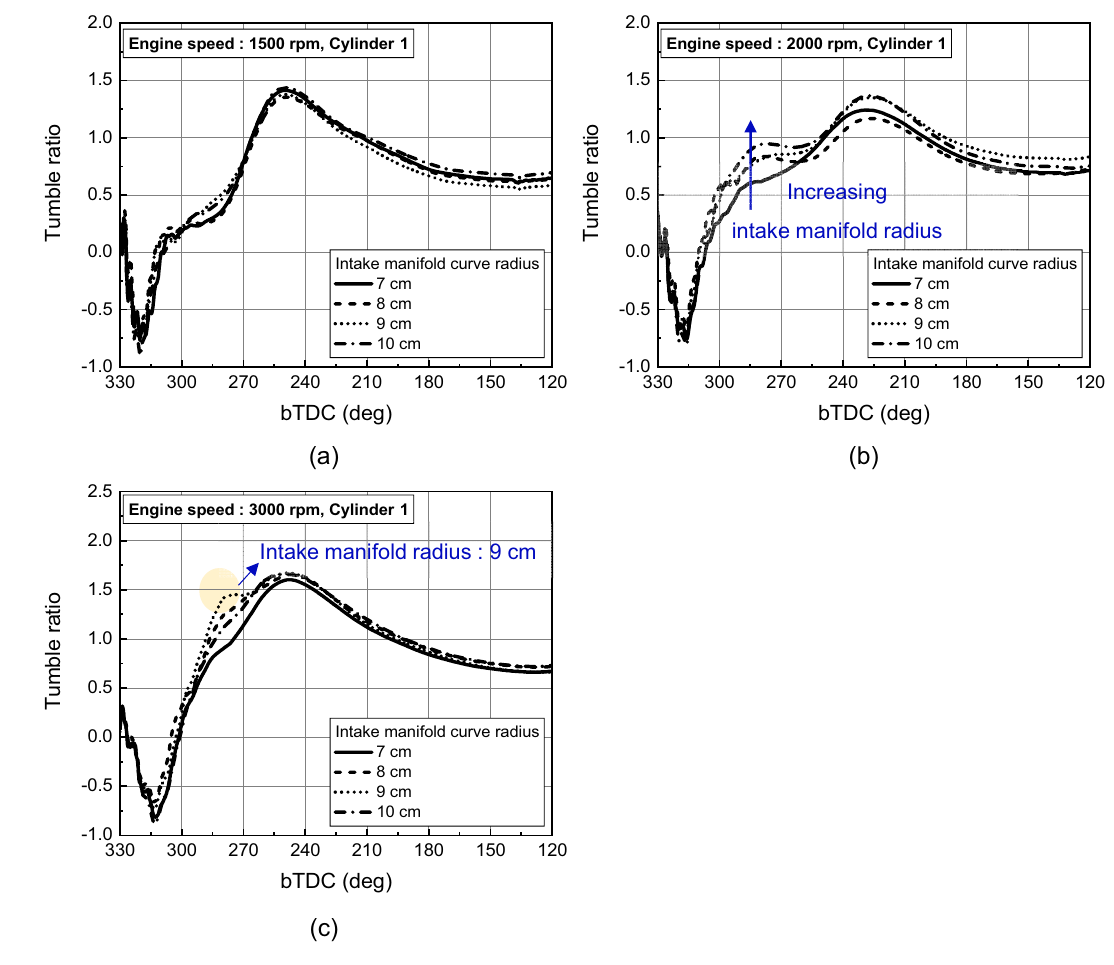
Figure 24. Tumble ratio for different intake manifold curve radius at engine speed of ( a ) 1500 rpm, ( b ) 2000 rpm, and ( c ) 3000